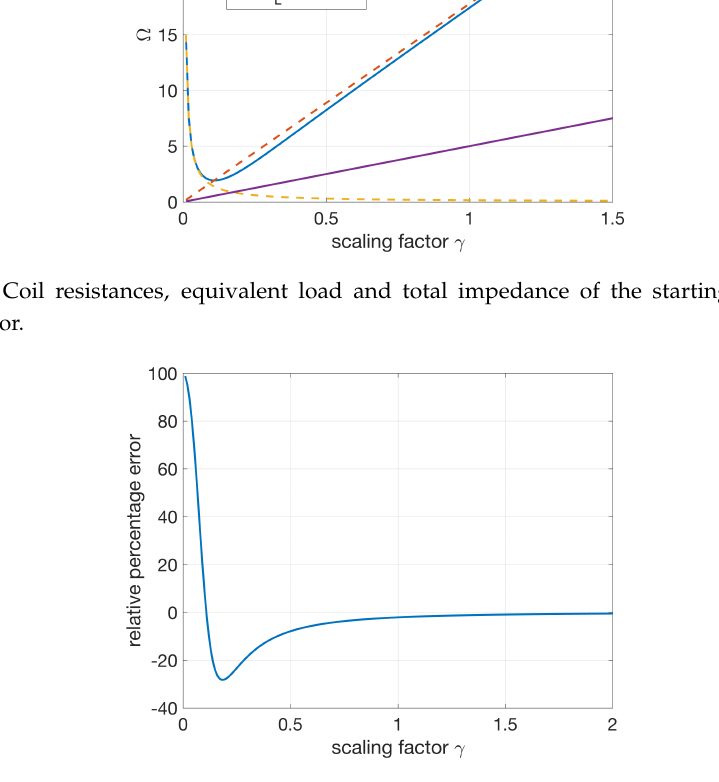
Figure 5. Relative error of lossless total impedance with respect to the lossy one.